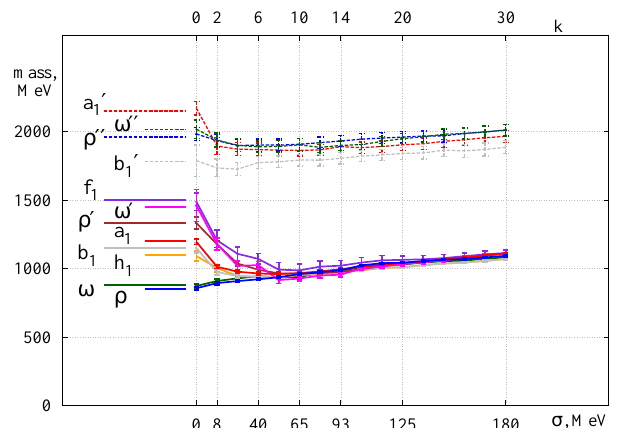
Figure 2. J = 1 meson mass evolution as a function of the truncation number k . σ shows the energy gap in the Dirac spectrum. The figure is from Ref. [7].